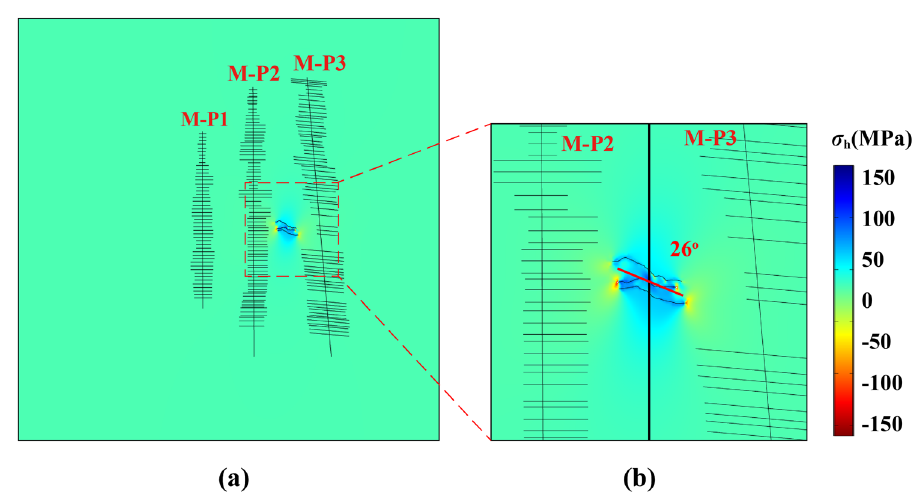
Fig.16 The fracture configura- tion of the 16th stage of M-I2 after parent well